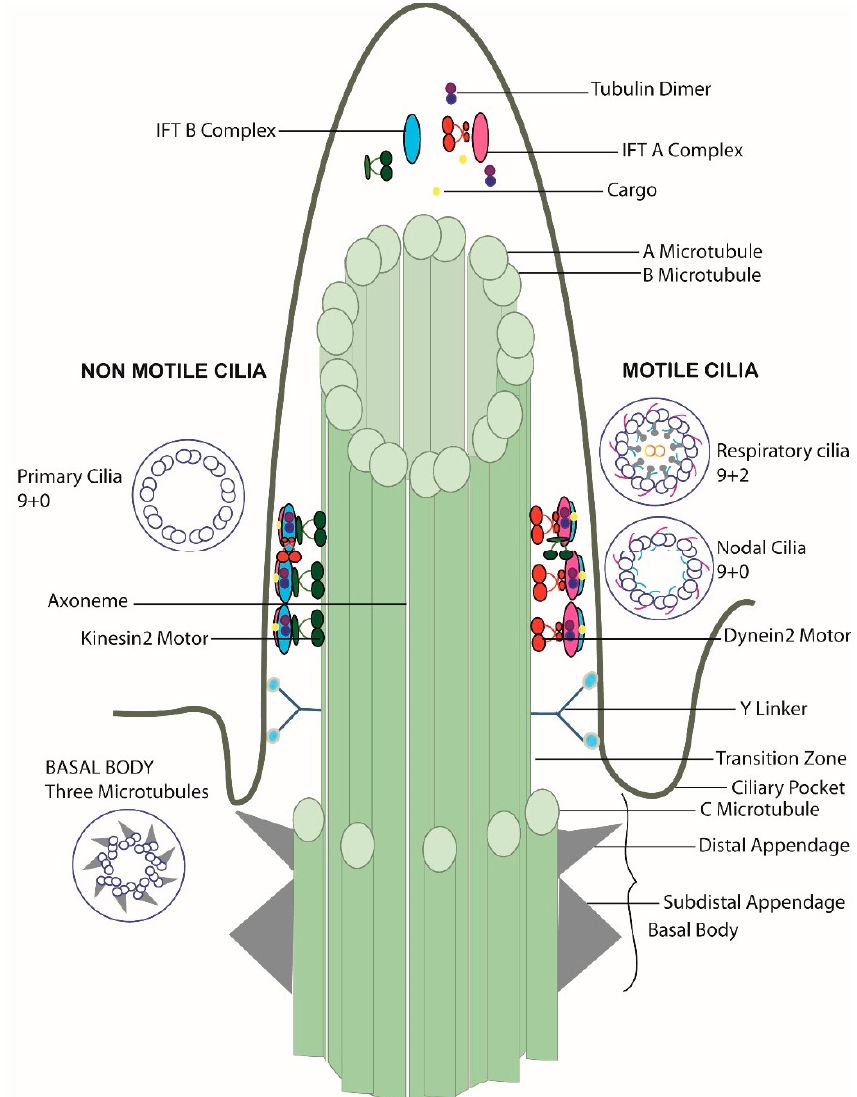
Figure 1. Structure of the cilia. Primary cilia with a 9 + 0 microtubule arrangement lacking dynein arms are usually immotile; respiratory epithelium cilia with a 9 + 2 microtubule arrangement with dynein arms, radial spokes, and a nexin dynein regulatory structure generate organized wave form movement while nodal cilia with a 9 + 0 microtubule arrangement with dynein arms generate a propelling rotational movement. Basal bodies show a triplet microtubule pattern.